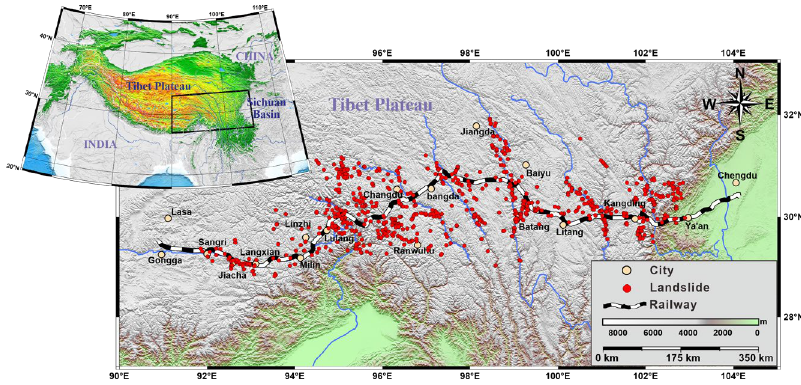
Figure 2. Landslide Study Area of the Sichuan-Tibet Transportation Project.